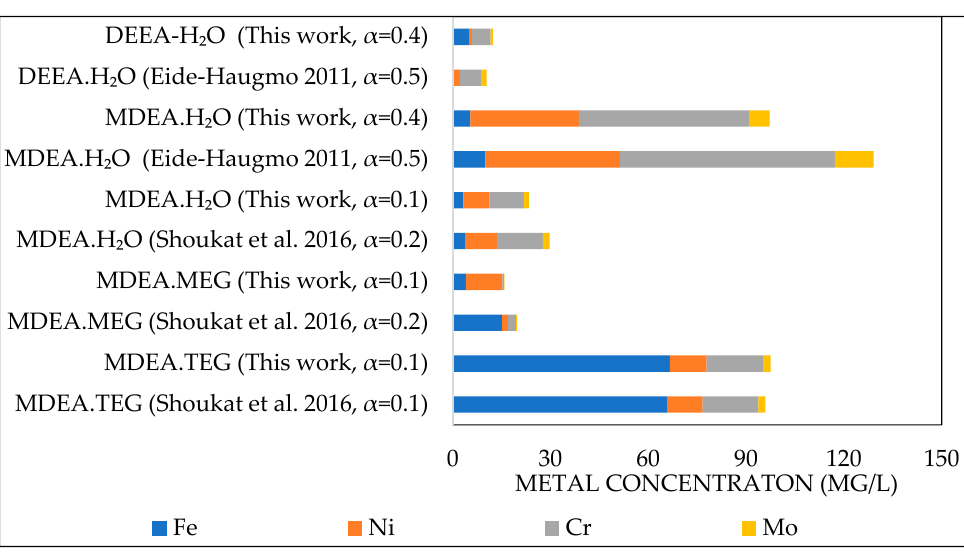
Figure 3. Total metal concentrations in 30 wt.% amine blends (Eide-Haugmo 2011 [35], Shoukat et al. 2016 [10]).